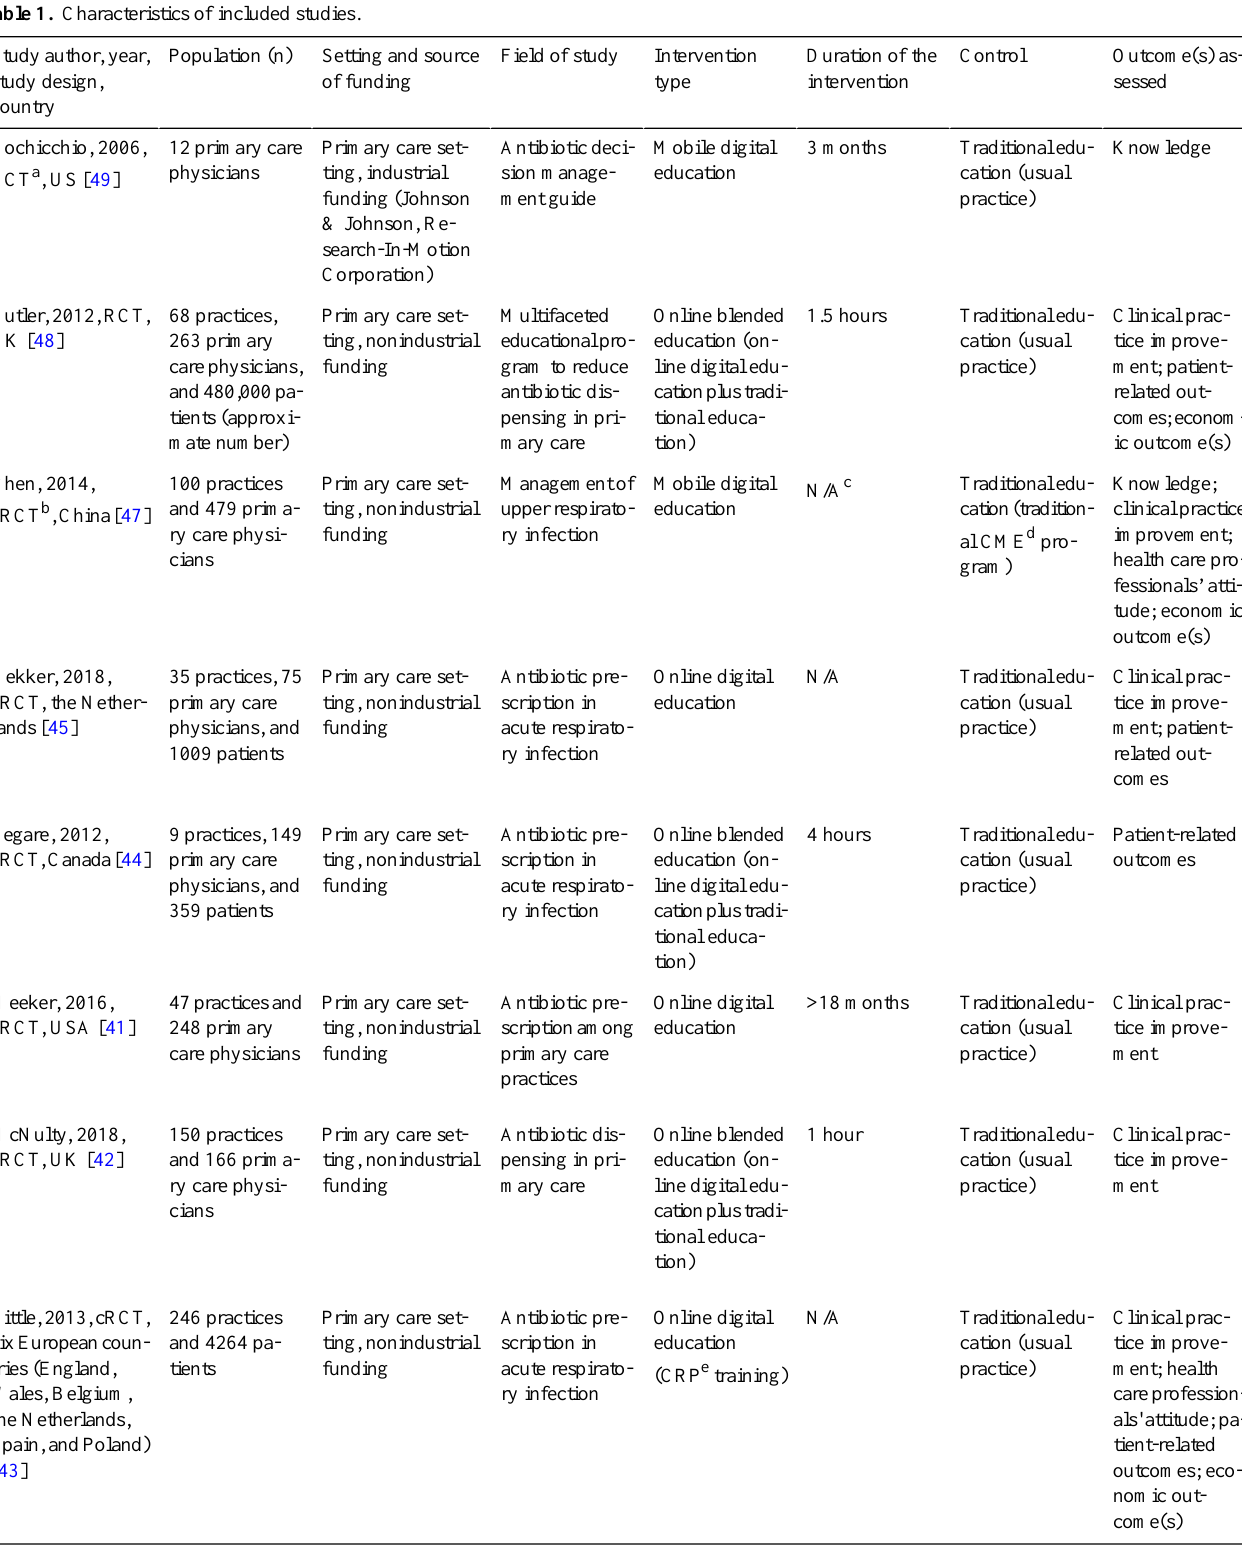
Table 1. Characteristics of included